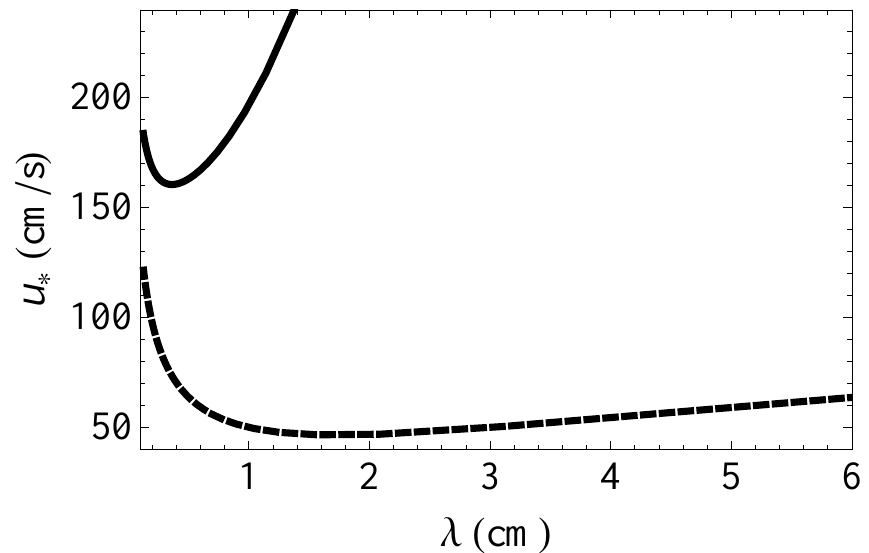
Figure 6. Critical value of u ∗ corresponding to the occurrence of the second mode is plotted against the wavelength λ . Continuous line: using the sheared gravity-capillary wave speed. The minimum value of u ∗ , for the occurrence of the second mode, is approximately u ∗ (cid:39) 160 cm s − 1 corresponding to a wavelength λ (cid:39) 0.35 cm. Dashed line: using the gravity-capillary wave speed in still water. The minimum value of u ∗ , for the occurrence of the second mode, is approximately u ∗ (cid:39) 45 cm s − 1 corresponding to a wavelength λ (cid:39) 1.74